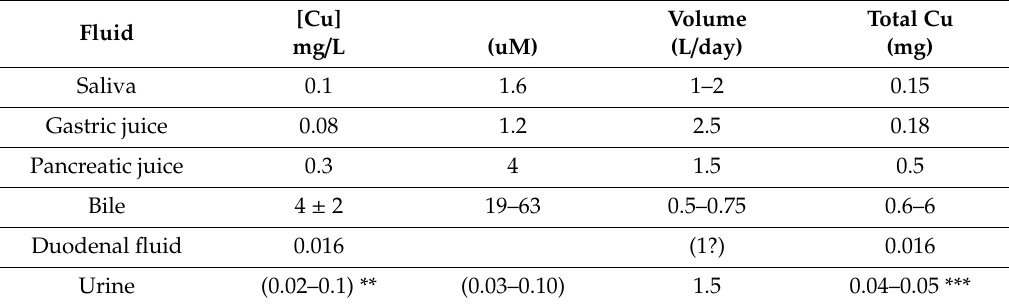
Table 1. Copper in Fluids of the Human Gastrointestinal Tract and Urine *.